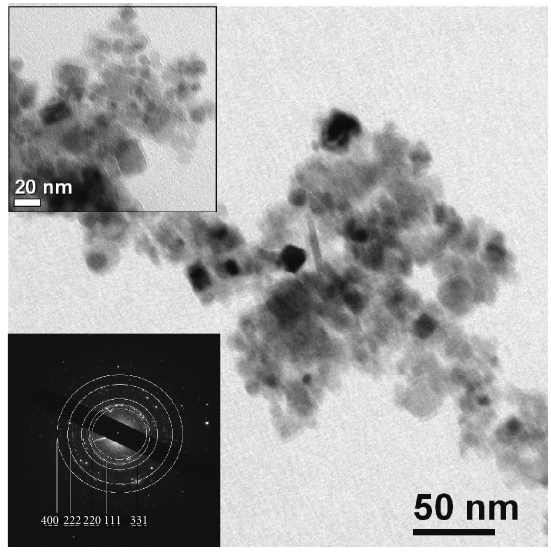
Figure 1: BF TEM micrographs and SAED patterns of as-prepared CoFe 2 O 4 –Fe 3 O 4 magnetic nanocomposites.